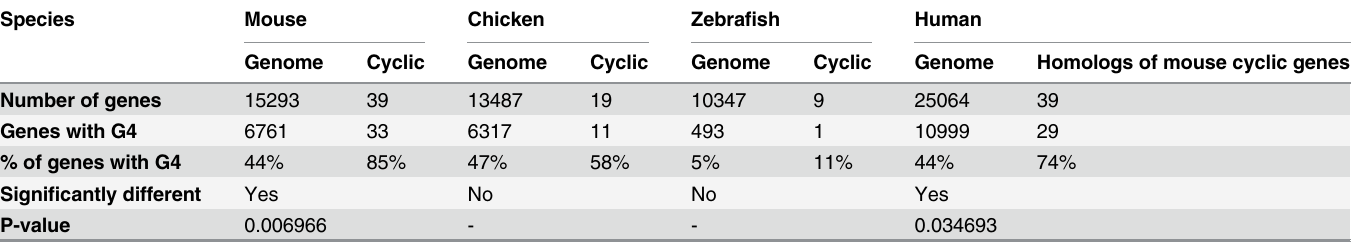
Table 5. Distribution of G-quadruplex structures in the promoter regions of mouse, chicken, zebrafish, and human genes. We computed the distri- bution of G4 in the promoter (2 kbps upstream of the TSS) of mouse, chicken, zebrafish, and human genes and compared to that of corresponding cyclic genes. As cyclic genes in human are not well defined, we used homologs of mouse cyclic genes for comparison purposes. G4 is significantly represented in the promoter of mouse cyclic genes. Indeed 85% of known mouse cyclic genes contain the G4 structures, suggesting a possible role during mouse somito- genesis. The p-value is computed using Fisher exact